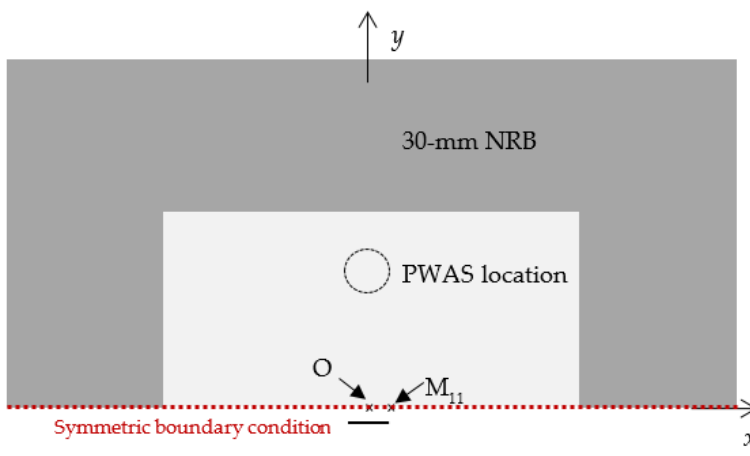
Sensors 2021 , 21 , x FOR PEER REVIEW